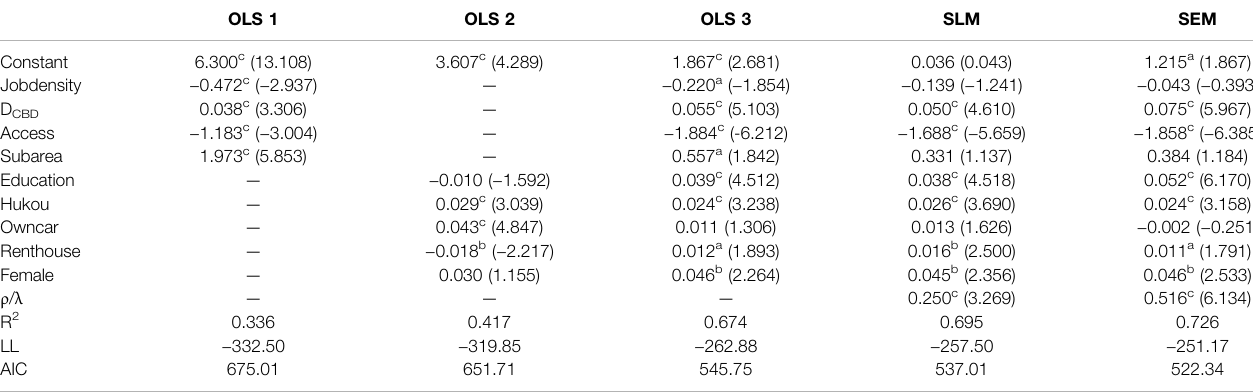
TABLE 2 | Model results of commuting